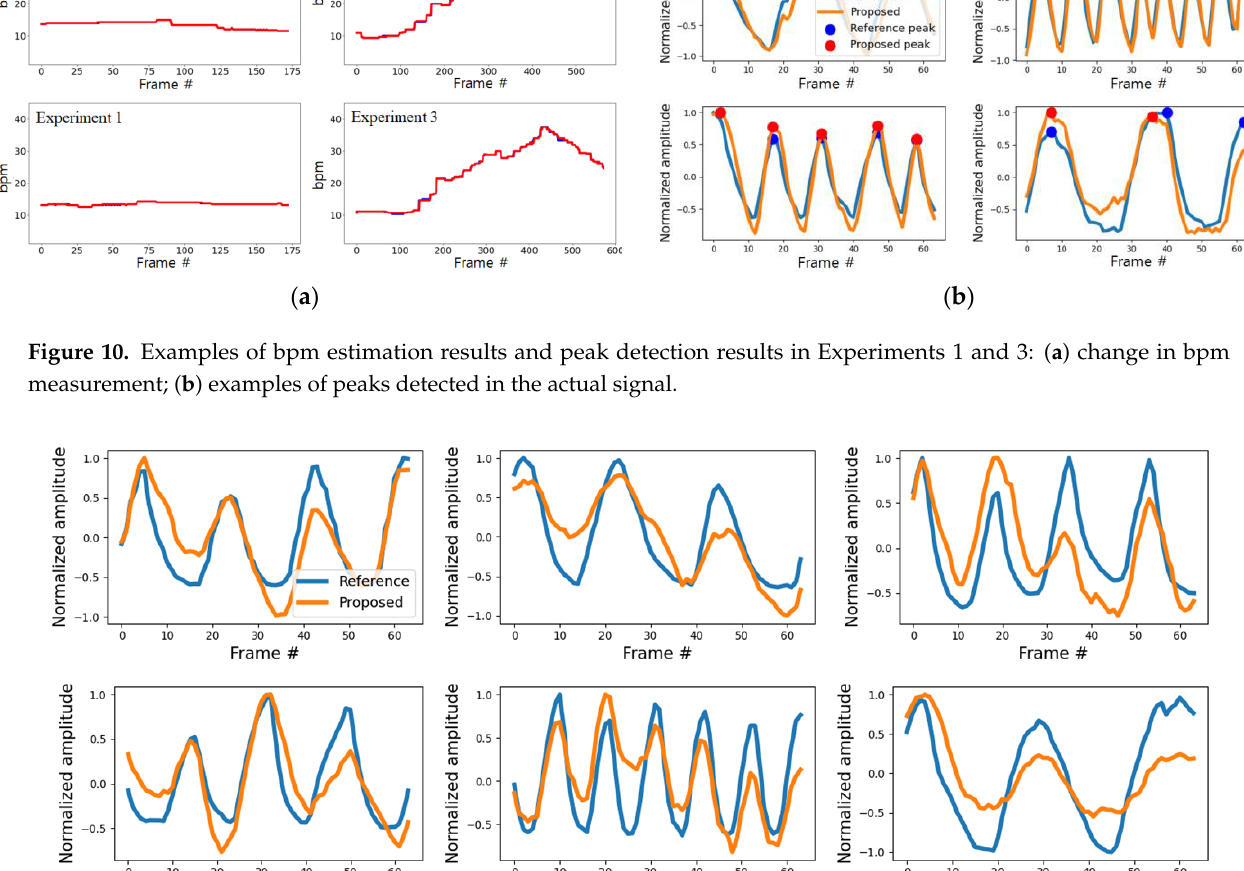
Figure 11. Comparison of signals in Experiment 2.